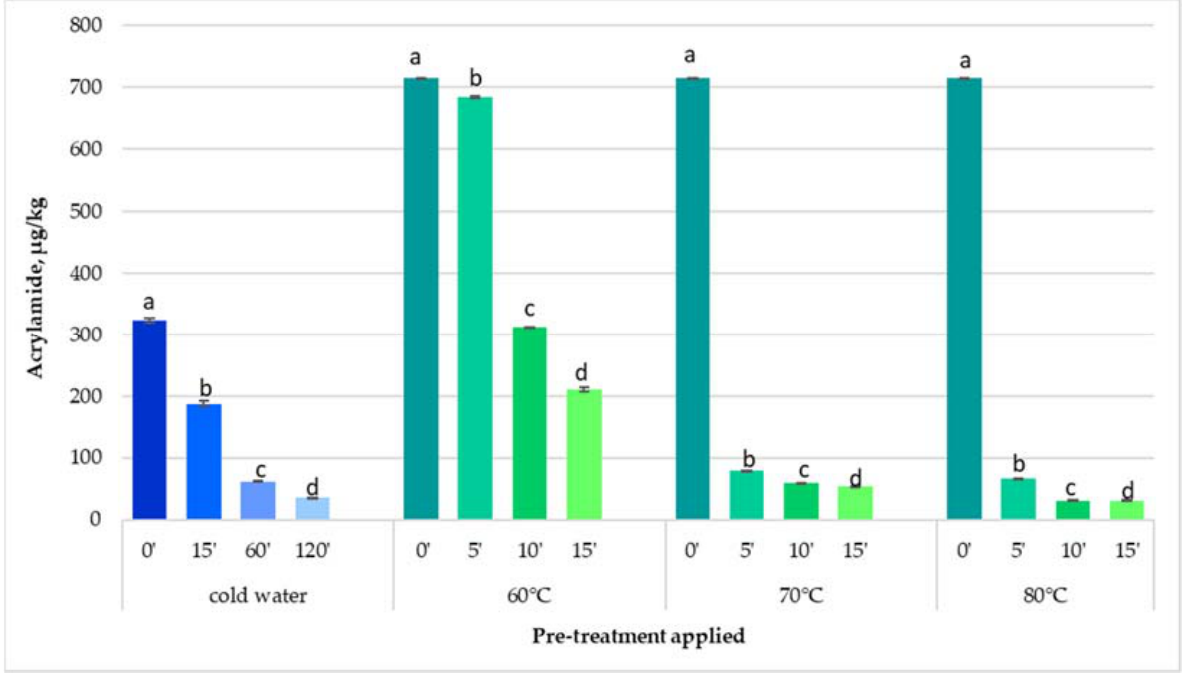
Figure 1. Effect of cold and hot water applied on potato strips on the acrylamide content of French fries fried in a pan. Values followed by different letters in the same column for each pre ‐ treatment are significantly different ( p < 0.05).